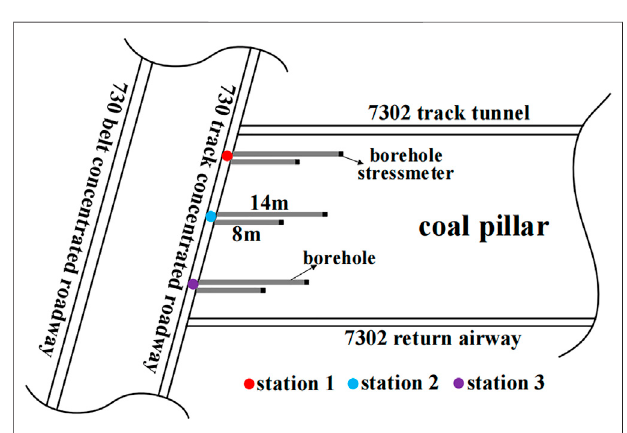
FIGURE 13 | Schematic diagram of station